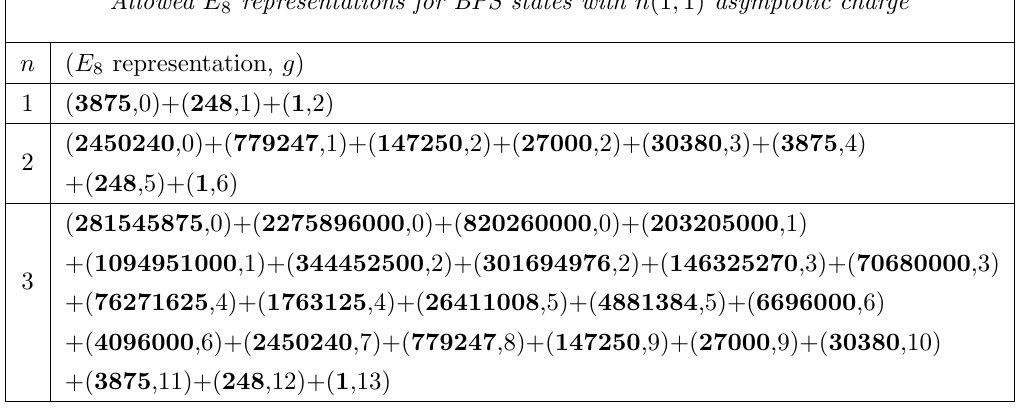
Table 7 . The allowed representation for BPS states with asymptotic charges n (1 ; 1), with 1 (cid:21) n (cid:21) 3, are listed. We also list the genus of the corresponding holomorphic